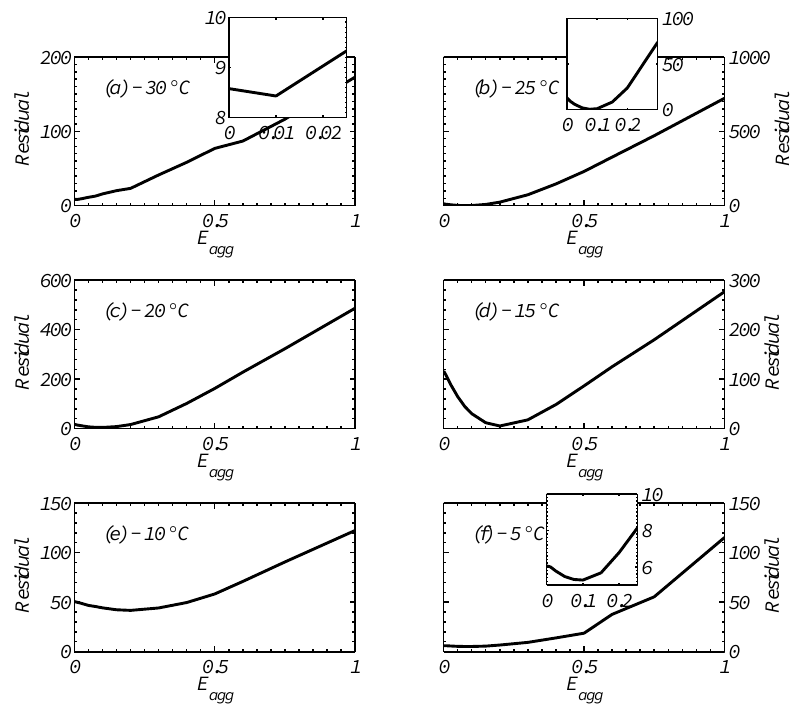
Fig. 12. Plots of the residual differences between the model and observations for the different experiments. Note the value of E agg where the residual is a minimum denotes the value of E agg that best matches the data or the maximum likelihood estimate. Inset are expanded plots for the cases where the minima are not clearly visible. Using inherent growth ratio of 0.55 Using inherent growth ratio of 0.45